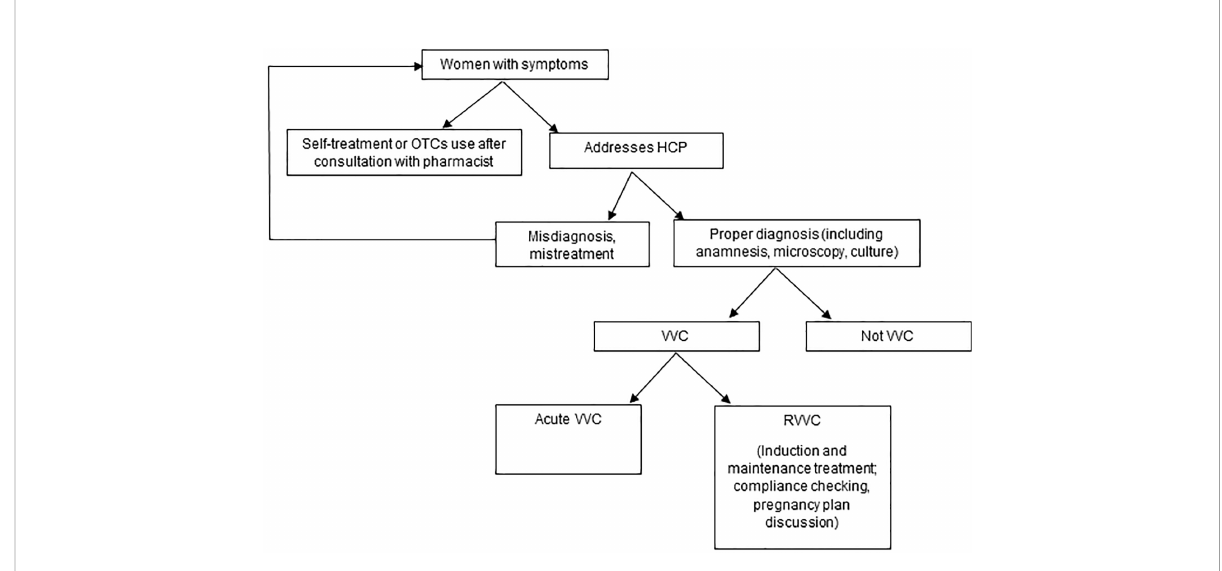
FIGURE 1 The patient pathway in the real